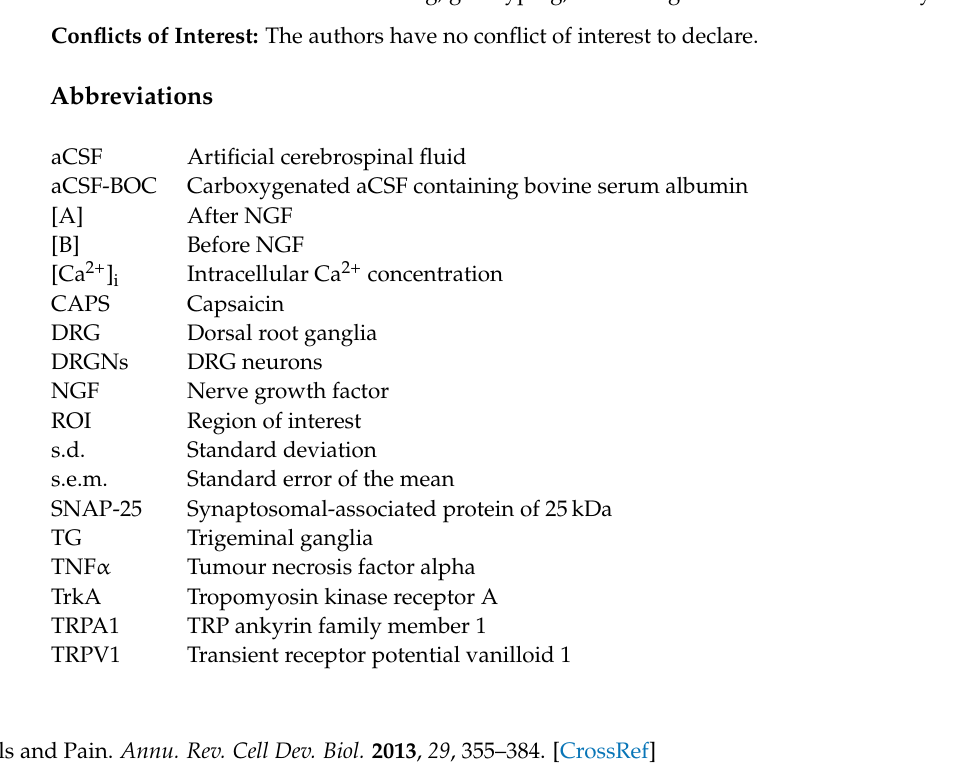
as a ratio in Figure 2C, Table S4: Statistical analysis of data plotted as a ratio in Figure 2D, Table S5: Statistical analysis of data in Figure 3B–D; comparisons between NGF-excitable and -refractory neurons., Table S6: Statistical analysis of part of the data in Figure 3B–D; comparisons between signals evoked by 1 µ M CAPS applied before and after NGF in neurons that were excited both times., Table S7: Statistical analysis of part of the data in Figure 4A–C; comparisons between signals evoked before and after NGF, Table S8: Statistical analysis of data in Figure 5A–C; comparisons between signals evoked by 1 µ M CAPS applied before and after NGF in neurons that were excited both times., Table S9: Statistical analysis of part of data in Figure 6C–E; comparisons between signals evoked in NGF-refractory cells and those excited once by NGF., Table S10: Statistical analysis of part of data in Figure 6C–E; comparisons between CAPS evoked signals in cells excited once by NGF with those activated